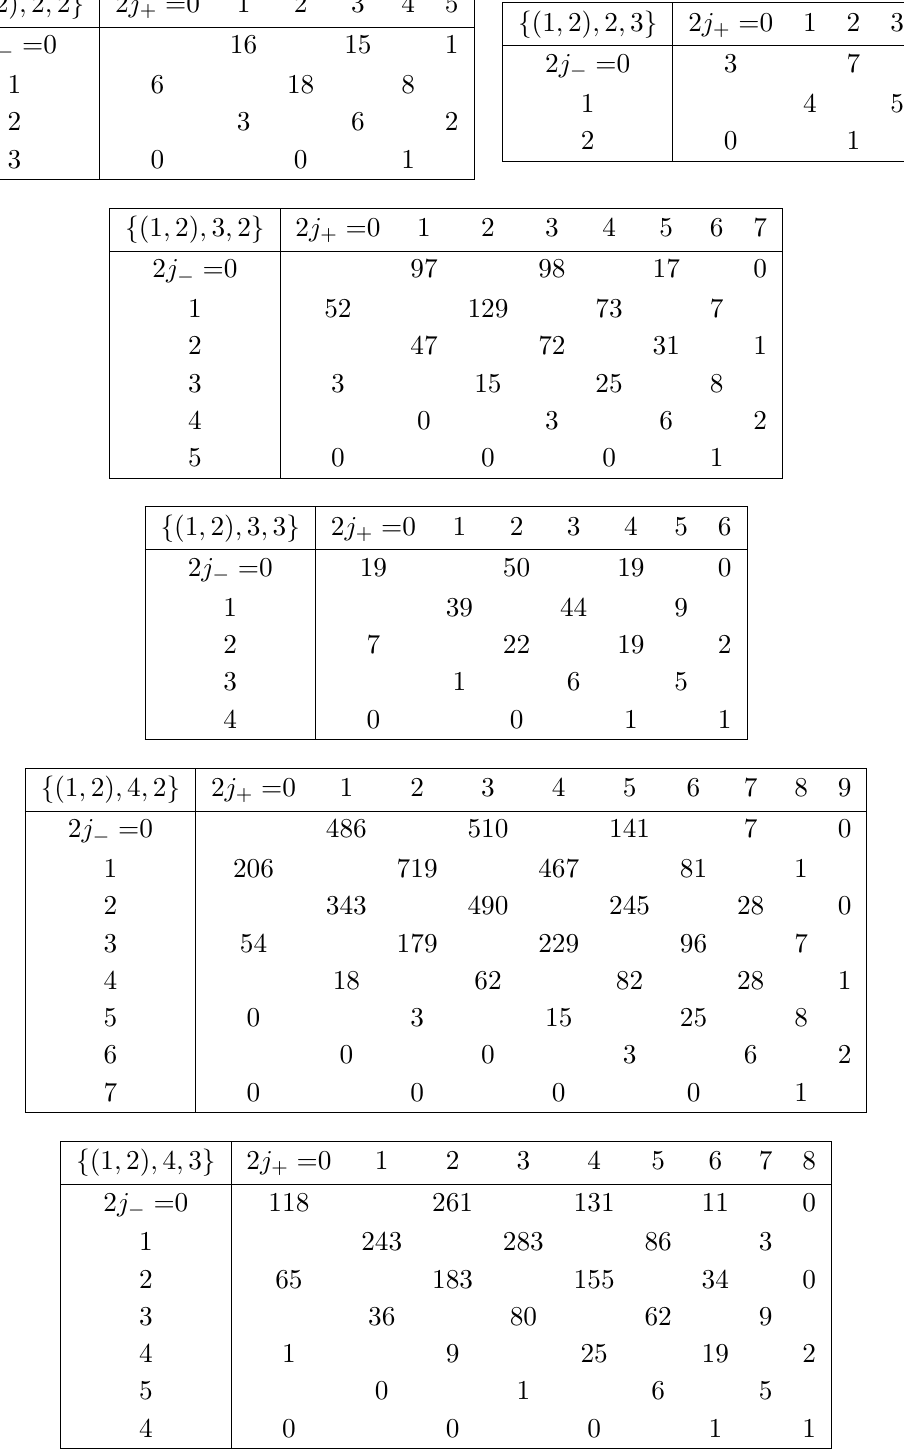
Table 14 . Refined GV invariants from 5d N = 2 theory of type G 2 , fiber degree 2, 3 and 4 with mass degree 2 and 3